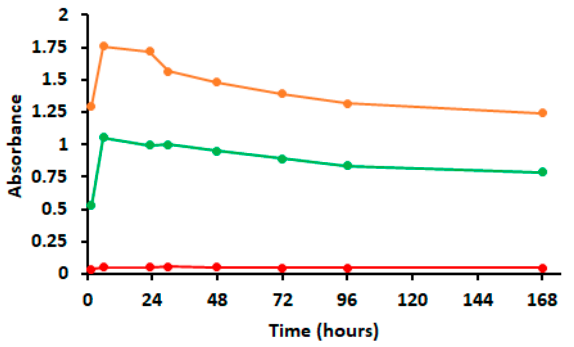
Figure 7. Kinetics of AP-EO release in its di ff erent formulations in PBS bu ff er solution. Green line = AP-EO, free essential oil of A. pusilla . Orange line = AP-EO/MSPs, essential oil of A. pusilla encapsulated in mesoporous silica particles. Red line = AP-EO/MSPs-Chi, essential oil of A. pusilla encapsulated in mesoporous silica particles coated with chitosan.